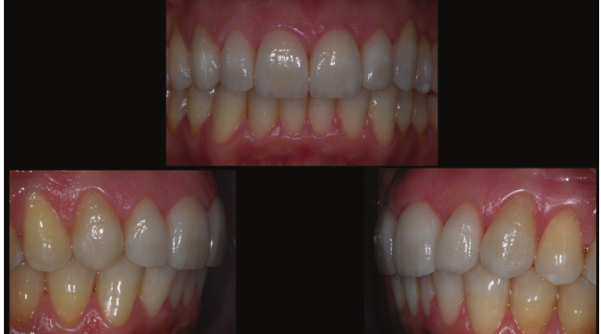
Figure 8: Case 2 (Bilayered Lithium Disilicate Veneer Replace- ment). The new veneers at the end of the treatment.